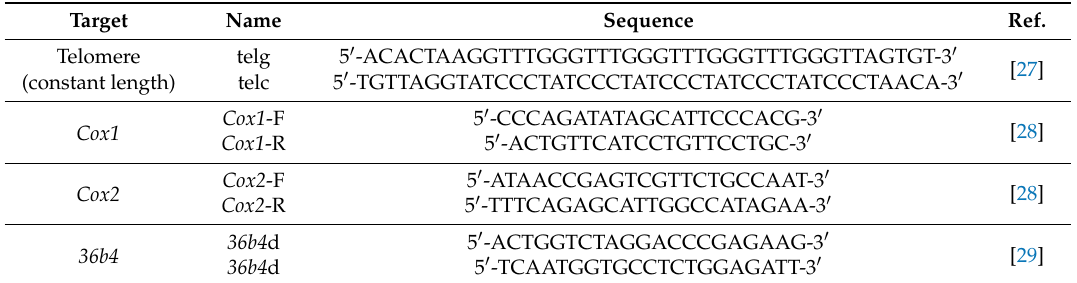
Table 1. Primers used for quantitative real-time